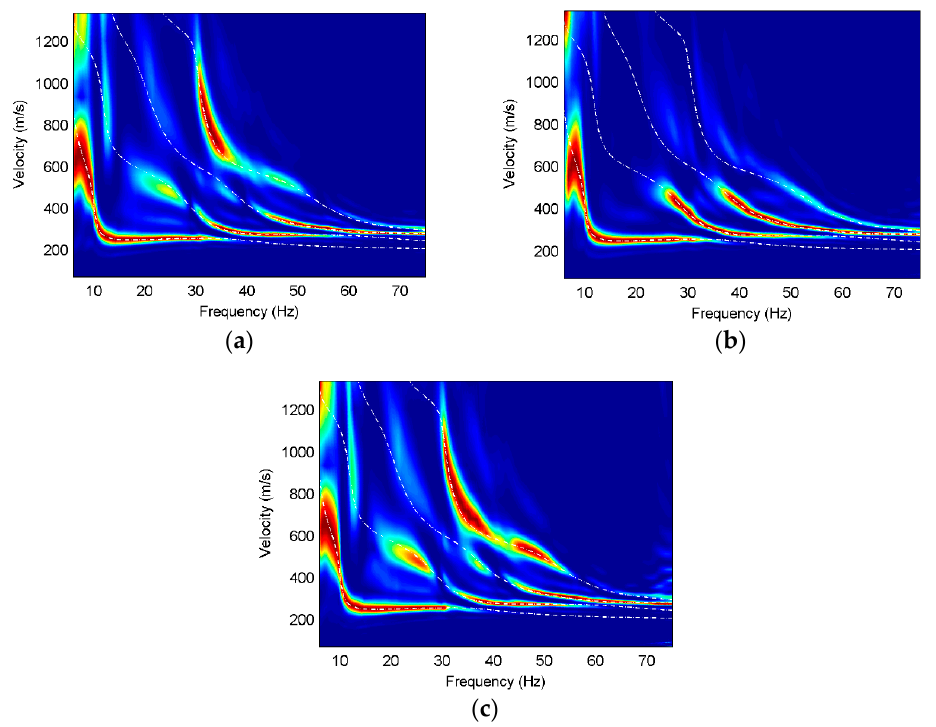
Figure 4. Dispersion images for Model 2, where the white dashed lines are the theoretical dispersion curves and the red color represents the maximum energy. ( a ) X component of Model 2; ( b ) Z component of Model 2; ( c ) R y component of Model 2.